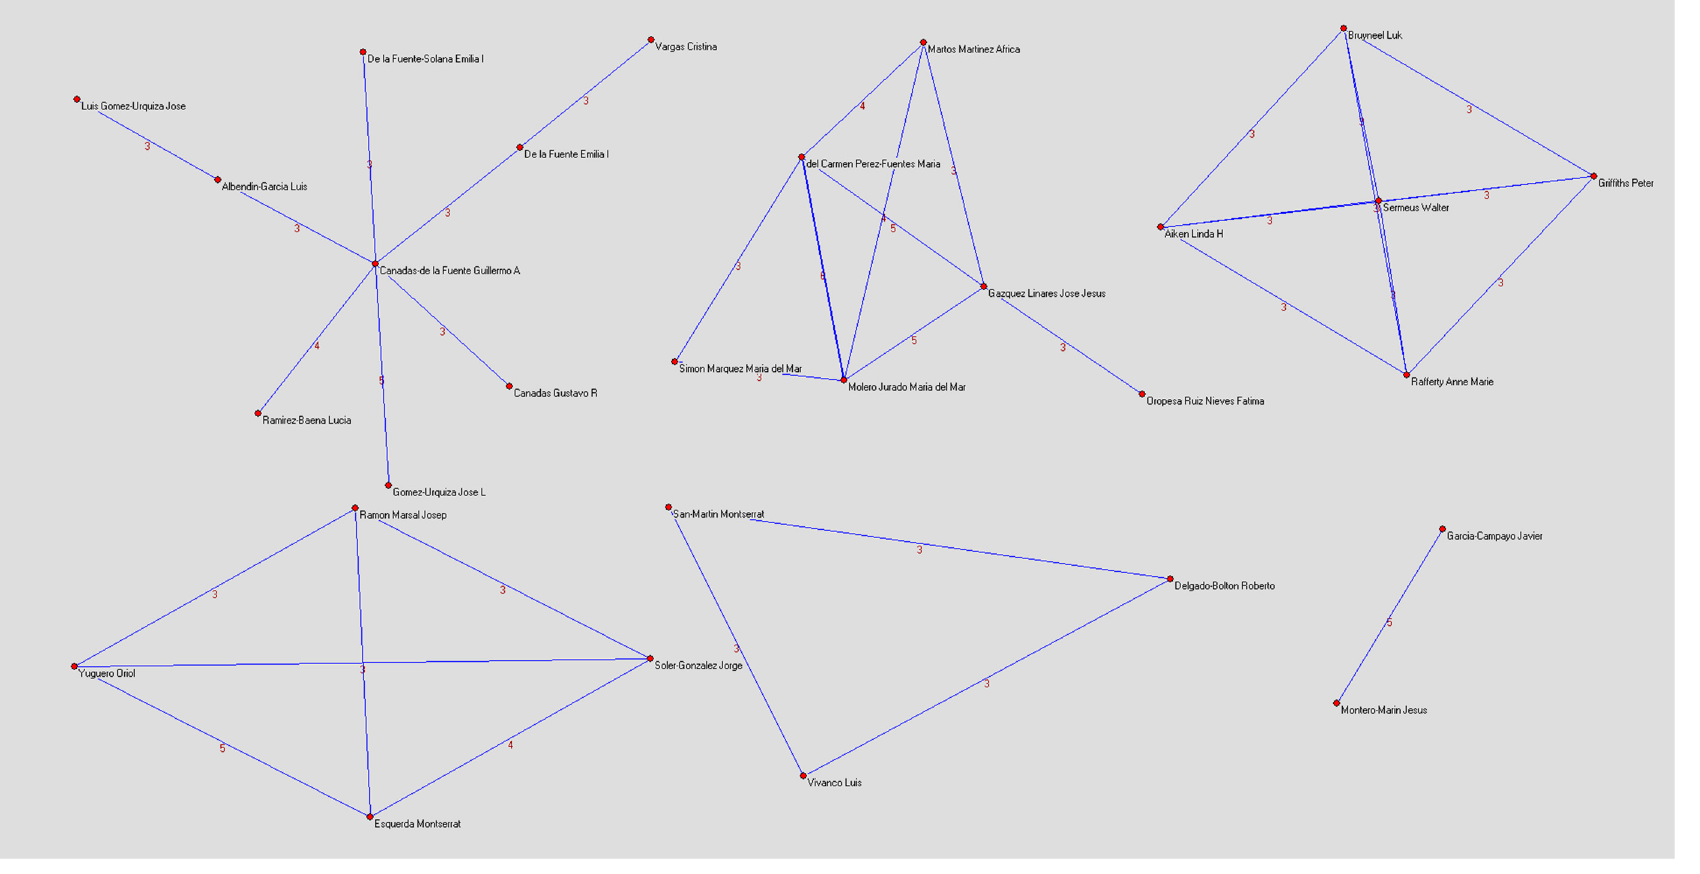
Figure 5. Co-authorship networks.